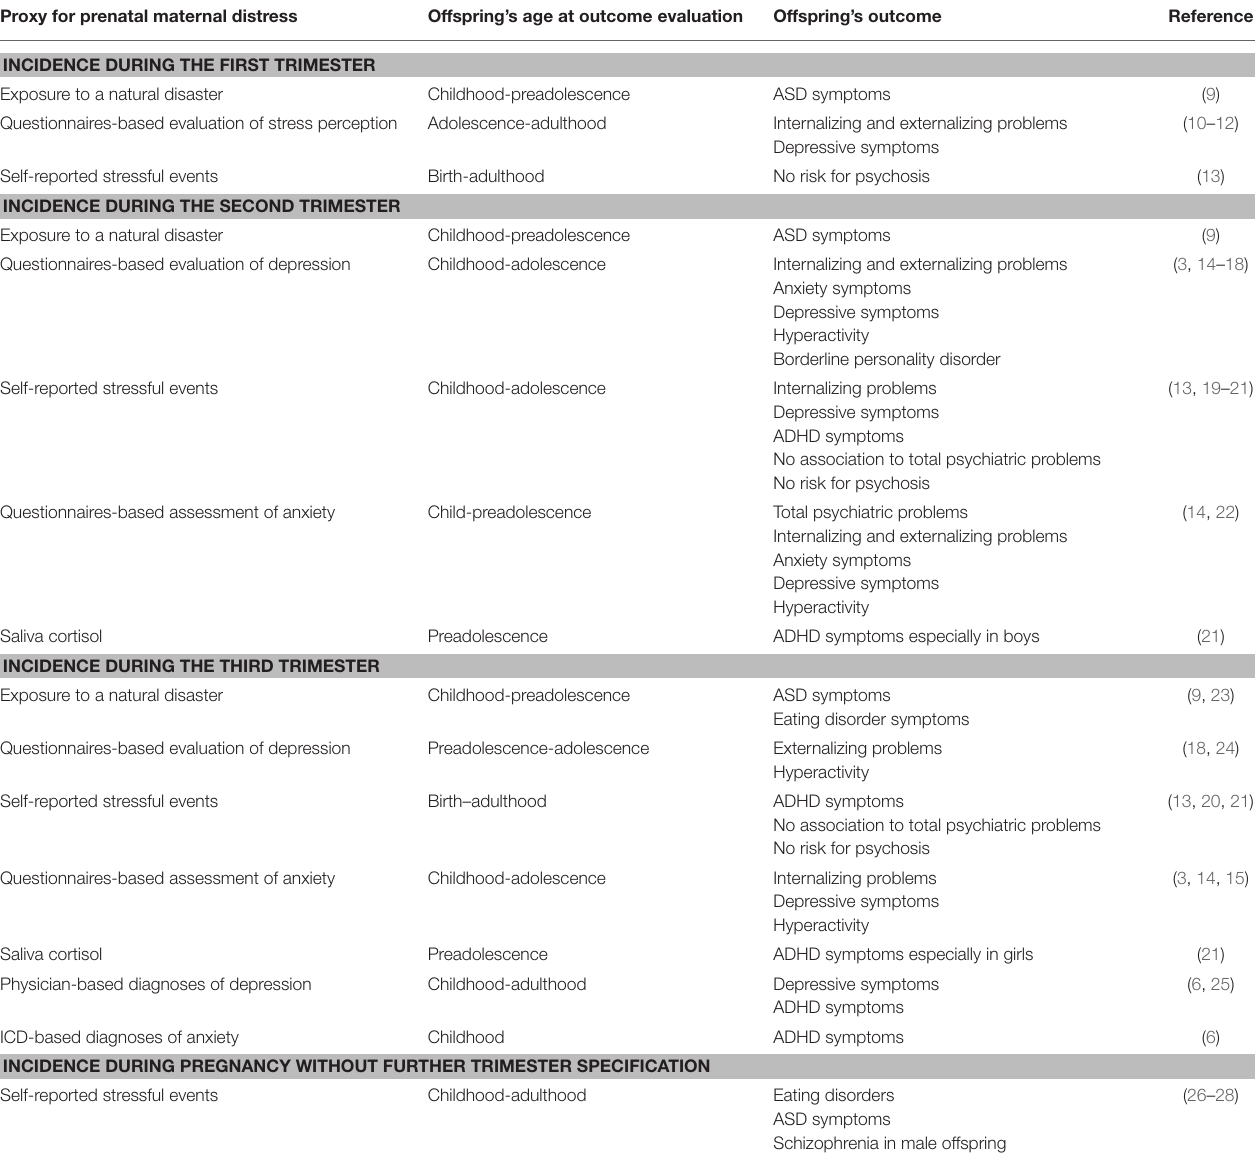
TABLE 1 | Summary of human studies examining the effect of prenatal maternal distress on offspring’s mental